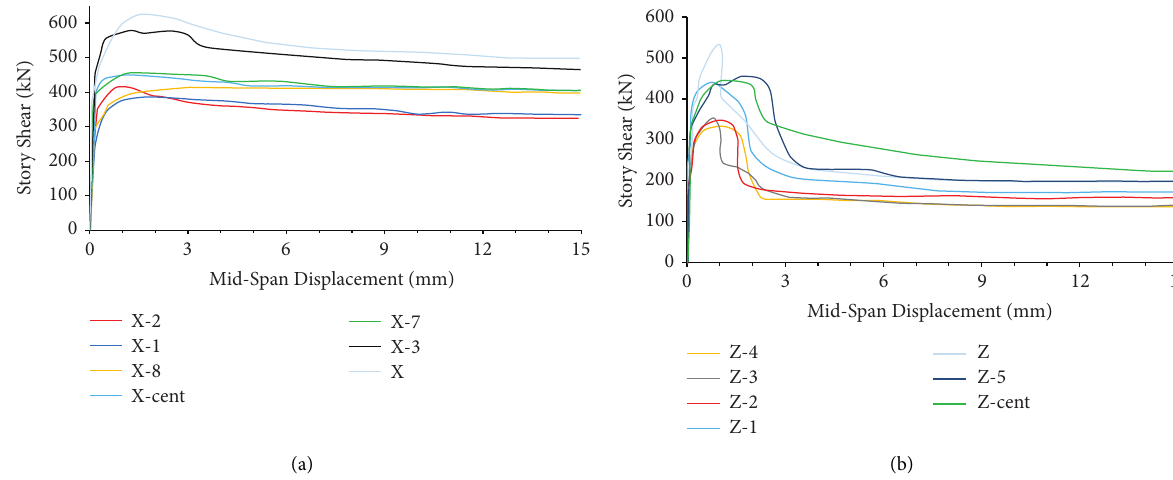
Figure 16: Floor shear chart against displacement in the middle of diaphragm opening for models with opening with different layouts with loading in various directions. (a) Loading in X direction. (b) Loading in Z